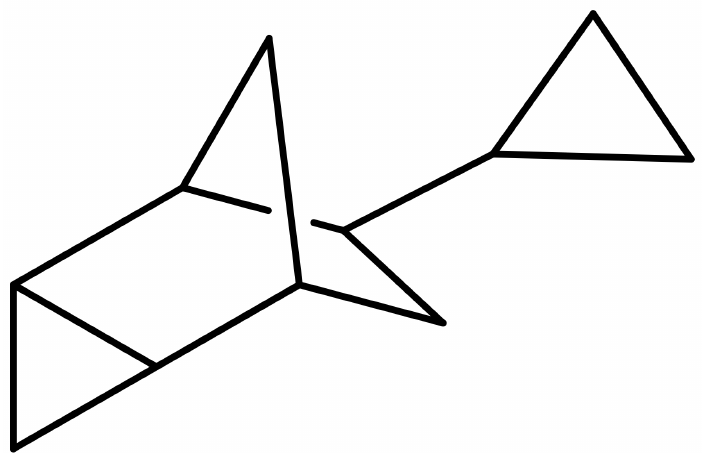
Figure 1. The molecular structure of dicyclopropanated 5-vinyl-2-norbornene